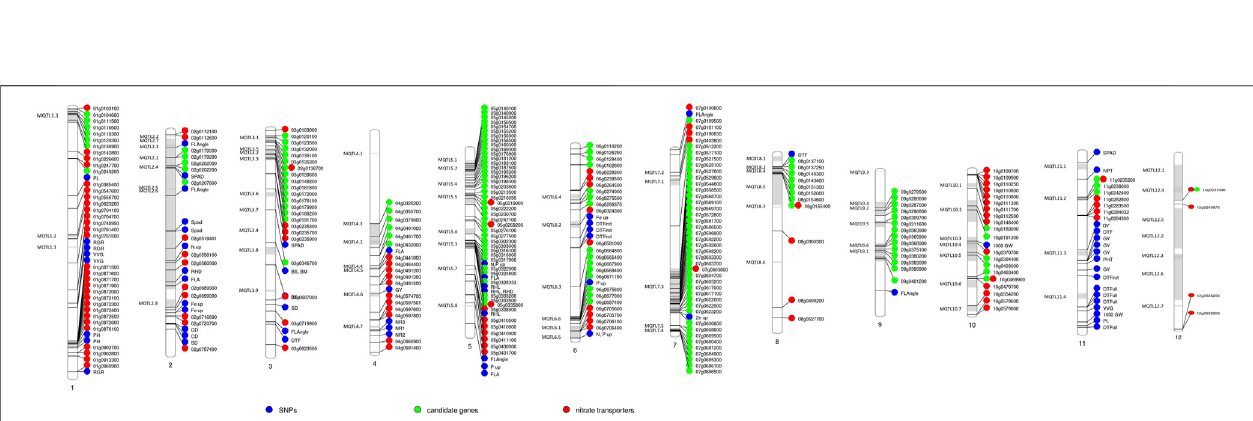
FIGURE 5 | Schematic representation of the distribution of previously reported single nucleotide polymorphism (SNP) associated with traits of interest, candidate genes reported in the present study, and the nitrate transporter along the 7 chromosomes of rice. The chromosome map showing MQTL identi fi ed in the present study and their co-location with the previously reported single nucleotide polymorphism (SNP) associated with different nitrogen use ef fi ciency (NUE) – related trait, root traits, yield, and yield-related traits (Sandhu et al., 2015; Sandhu et al., 2019; Subedi et al., 2019), candidate genes reported in the present study, and the nitrate transporter reported in rice. The numbers below each rice chromosome indicate chromosome